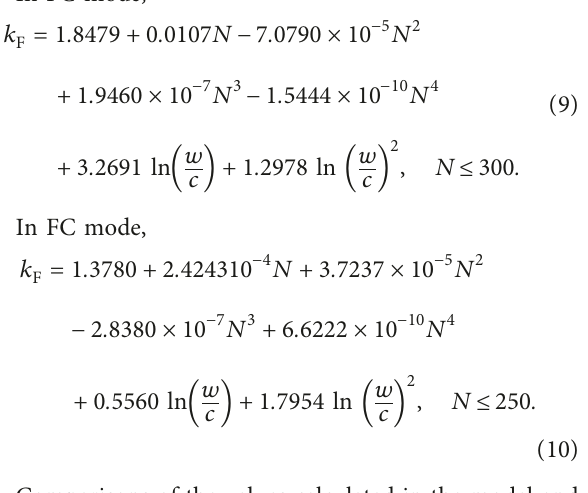
Table 9: Calculated values of k